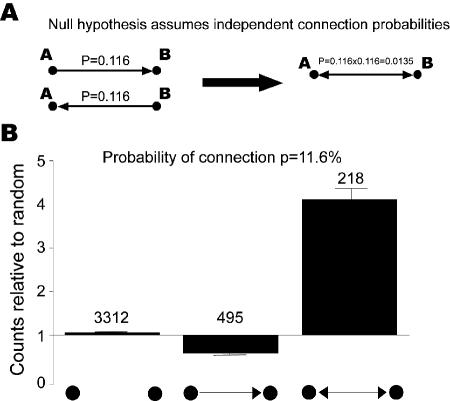
Two-Neuron Connectivity Patterns Are Nonrandom(A) Null hypothesis is generated by assuming independent probabilities of connection.(B) Reciprocal connections are four times more likely than predicted by the null hypothesis (p < 0.0001, Monte Carlo simulation to test for overrepresentation). Numbers on top of bars are actual counts. Error bars are standard deviations estimated by bootstrap method.